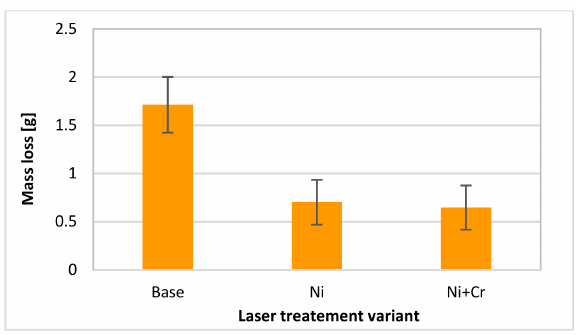
Figure 14. Mean weight loss after wear